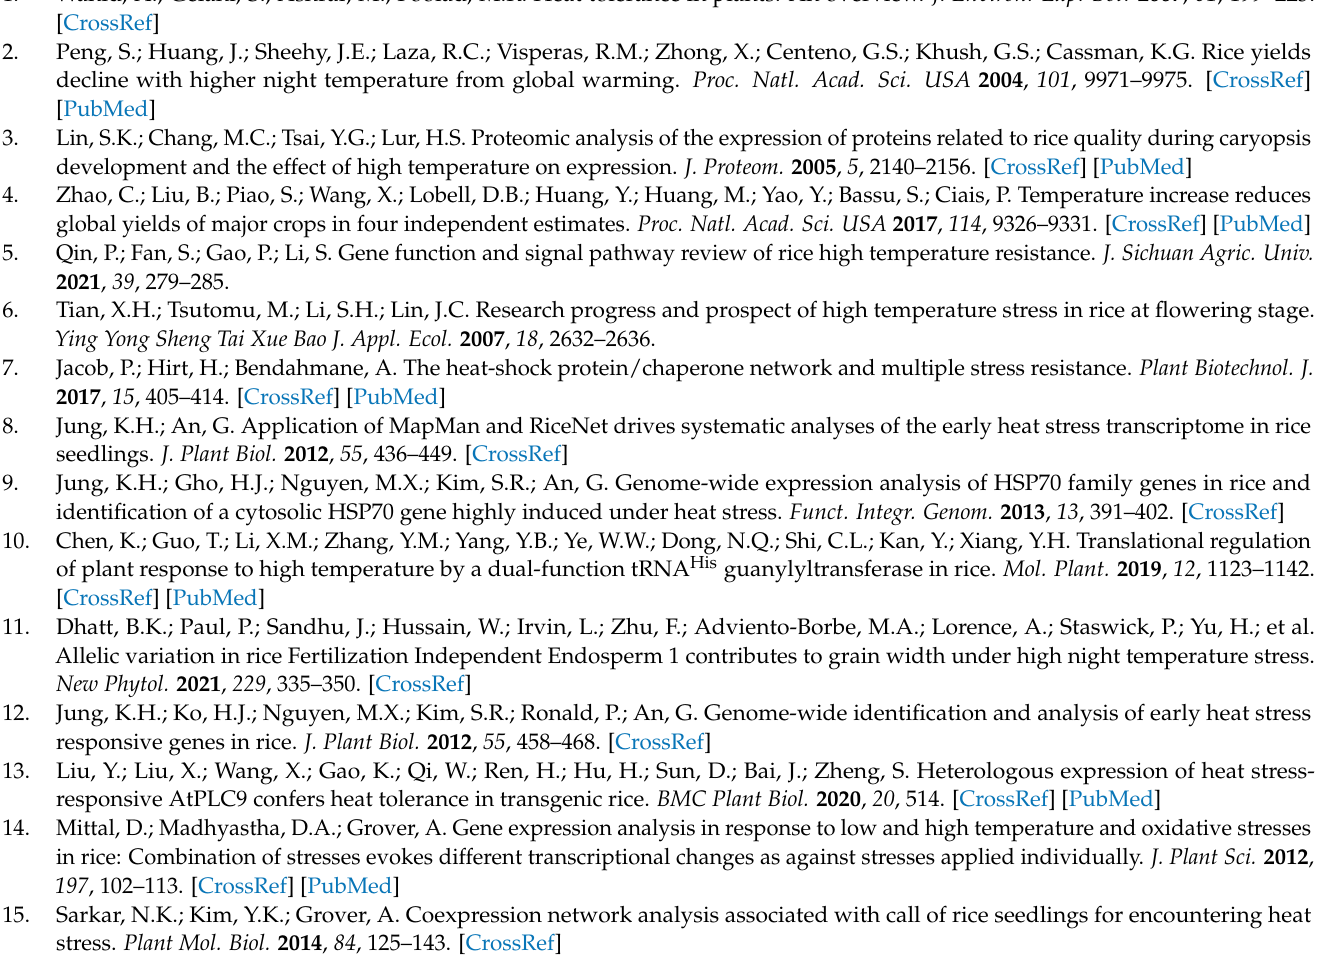
shock proteins. Table S4: Development-related genes. Table S5: Ubiquitin-mediated proteolysis system. Table S6: Hormone-signaling-related